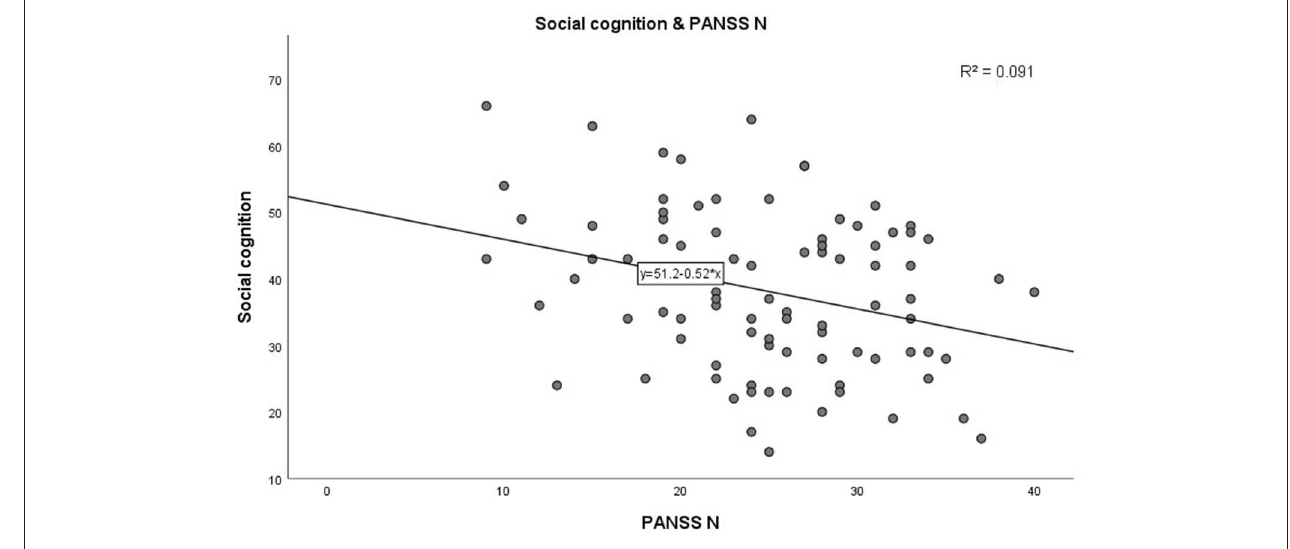
FIGURE 2 | Correlation between PANSS N and social cognition.